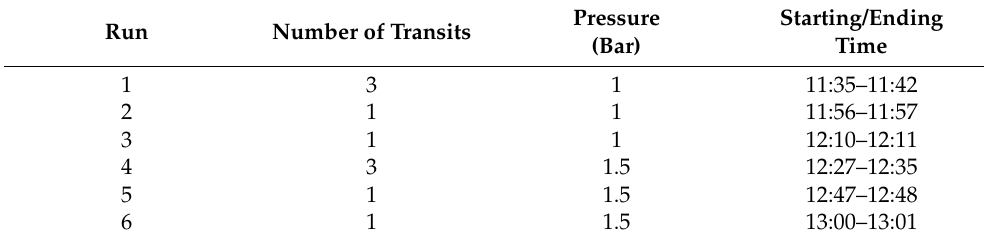
Table 1. Description and time sheet of measurements performed on spray-coating